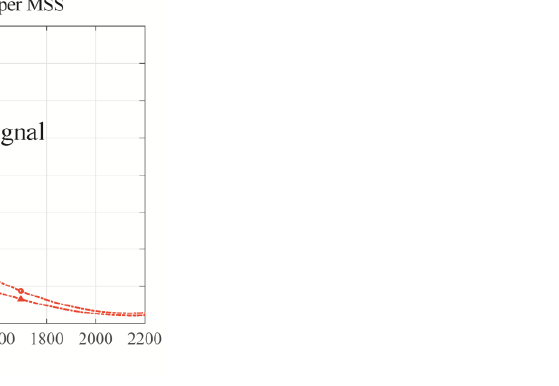
Figure 9. The influence of the relative test signal amplitude on the equivalent serial resistance measurement.